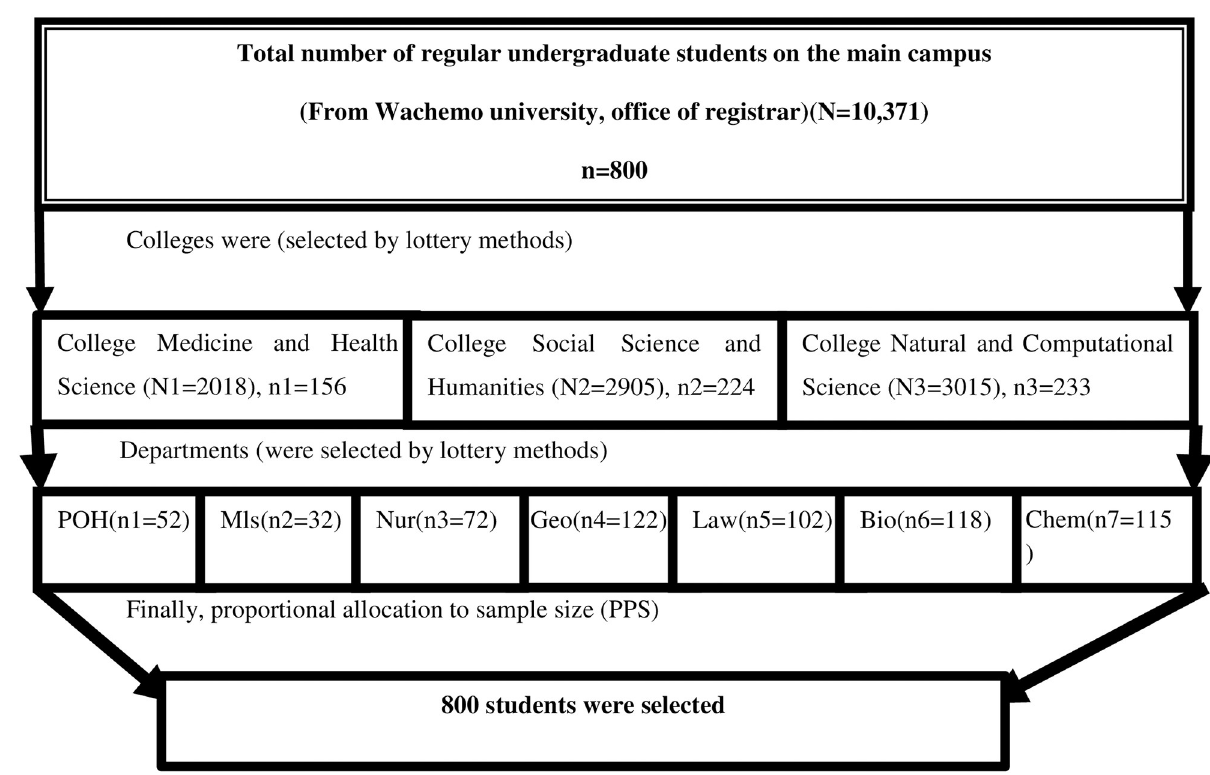
Fig 1. Schematic presentation of sampling procedure respondents on about knowledge, attitudes, and practices of face mask utilization and associated factors in COVID-19 pandemic among Wachemo university students, southern Ethiopia: February to March 2021 (n = 800). Where: POH = department public health officer, Mls = department of medical laboratory, Nur = department of nursing, Geo = department of geography, Law = department of law, Bio = department of biology and Chem = department of